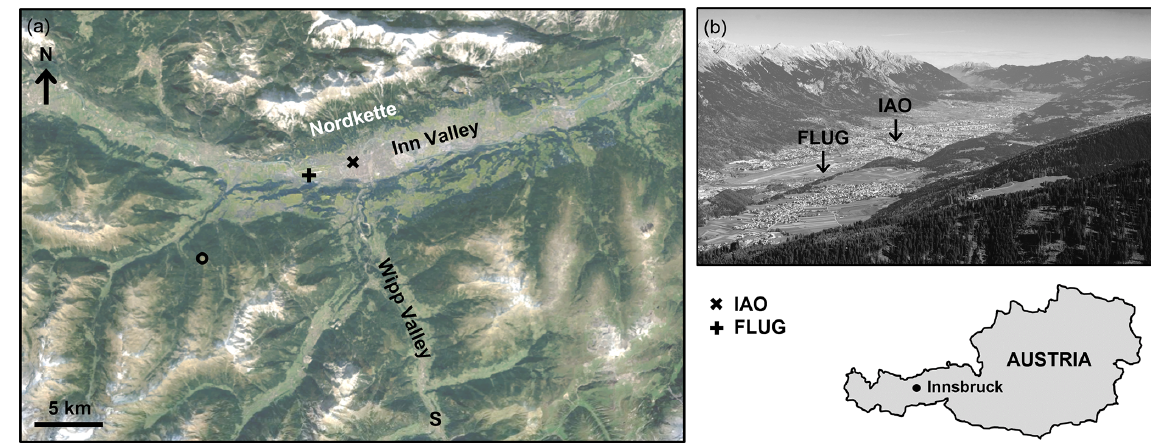
Figure 1. (a) Location of the Innsbruck Atmospheric Observatory (IAO) and airport (FLUG) sites in the Inn Valley and Steinach (S) in the Wipp Valley (aerial imagery from © Google Earth). (b) Photograph taken from the position marked with an open circle in panel (a) , looking eastwards along the Inn Valley over Innsbruck Airport and the city of Innsbruck. The location of Innsbruck within Austria is shown (bottom